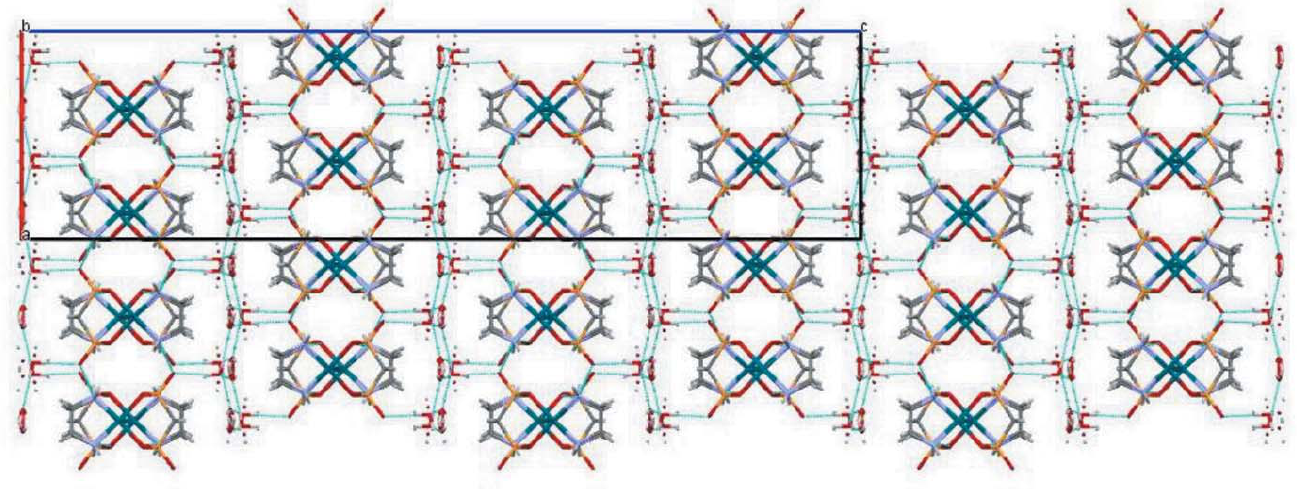
Figure 2 Crystal packing of the title compound in a view along [010] with hydrogen bonds shown as dashed